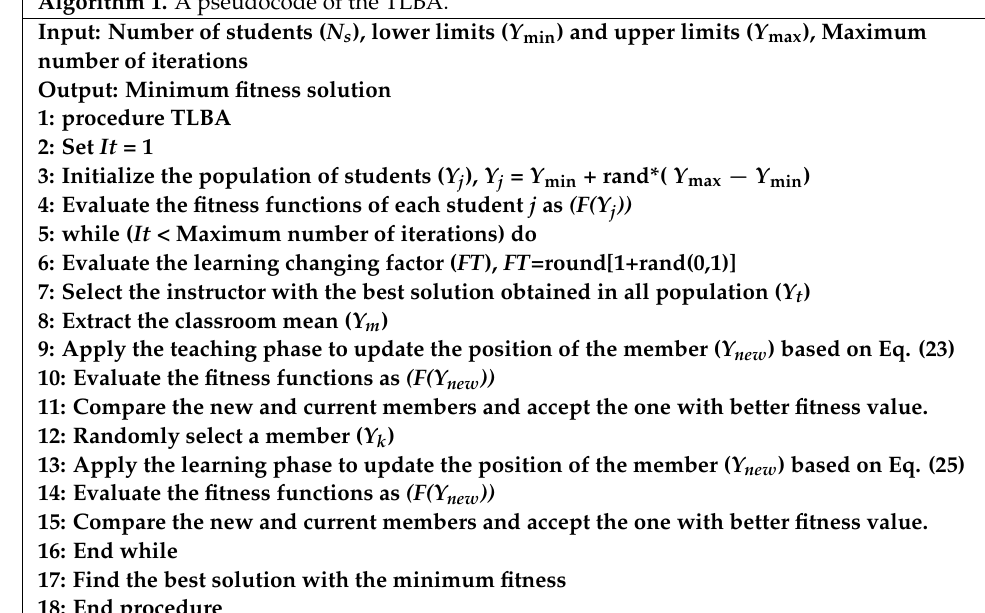
Algorithm 1. A pseudocode of the